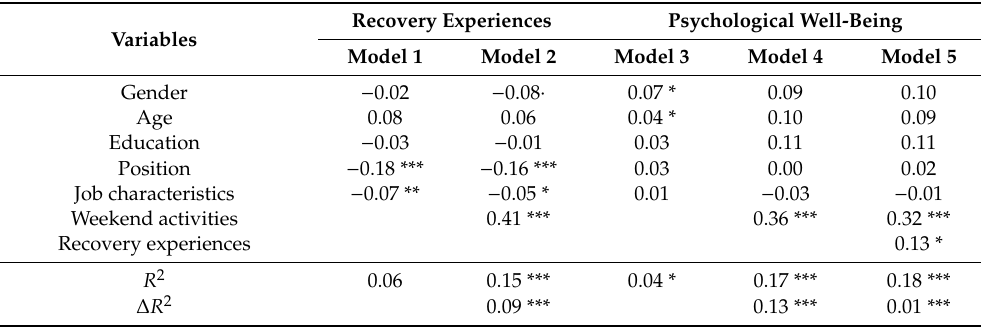
Table A1. Hierarchical multiple regression for recovery experiences and psychological